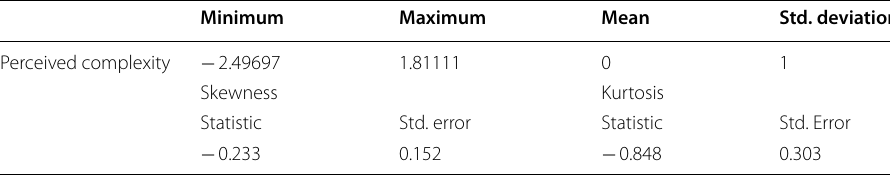
Table 3 Descriptive statistics of the “perceived complexity”